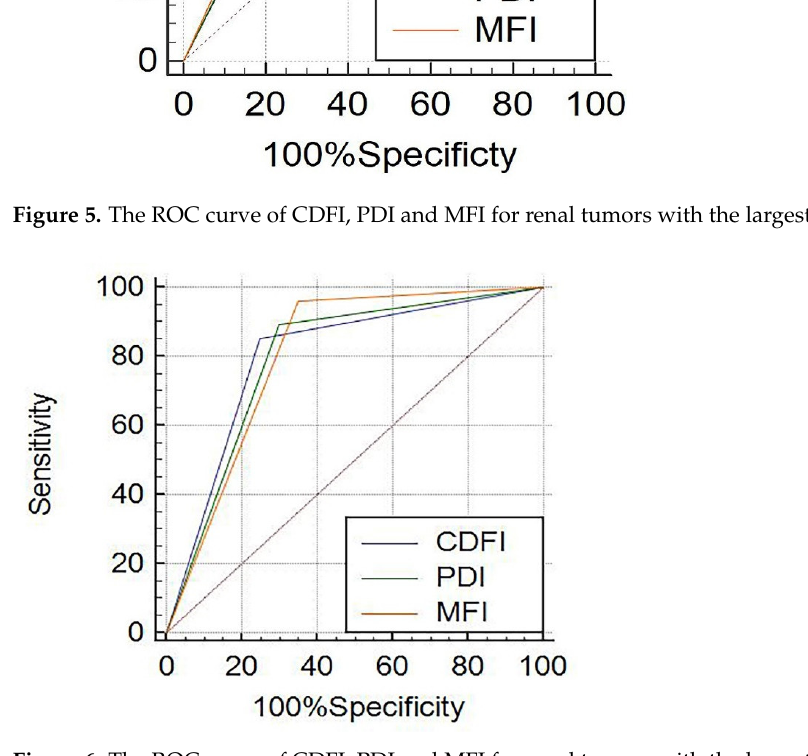
Figure 6. The ROC curve of CDFI, PDI and MFI for renal tumors with the largest diameter > 4 cm.